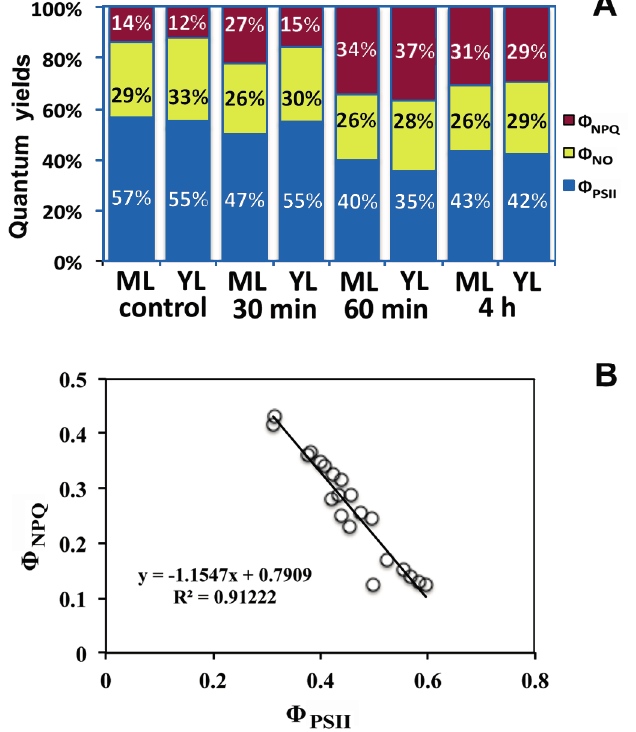
Figure 4. Complementary changes of ( A ) Φ PSII (quantum efficiency of PSII photochemistry), Φ NPQ (quantum yield for dissipation through down-regulation of PSII) and Φ NO (quantum yield of non-regulated energy dissipated in PSII), revealing the allocation of the absorbed light energy in PSII, of control and 30 min, 60 min, and 4 h after Pq exposure of A. thaliana mature and young leaves [data shown are means ( n = 6)]; and ( B ) relationship between Φ PS ΙΙ (quantum efficiency of PSII photochemistry) with Φ NPQ (quantum yield for dissipation through down-regulation of PSII) of control, and after 30 min, 60 min, and 4 h Pq exposure of A. thaliana mature and young leaves ( R 2 = 0.9122, p <